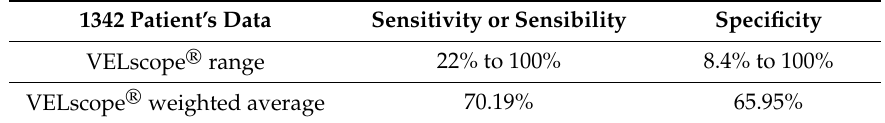
Table 2. Statistical data results.